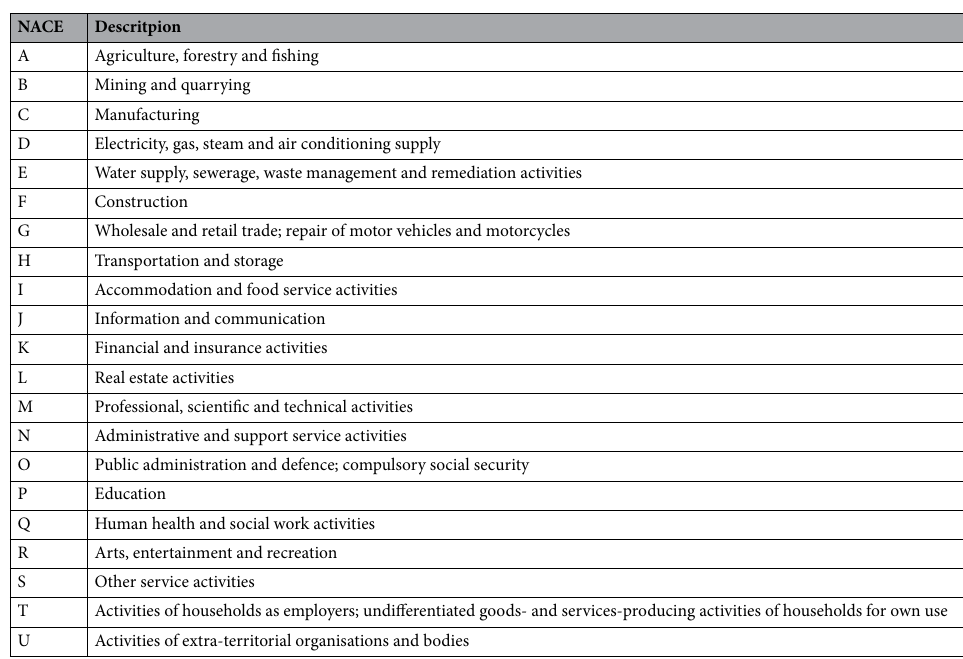
Table 3. NACE Rev.2, main division The description of the categories was taken from Ref. 99 .